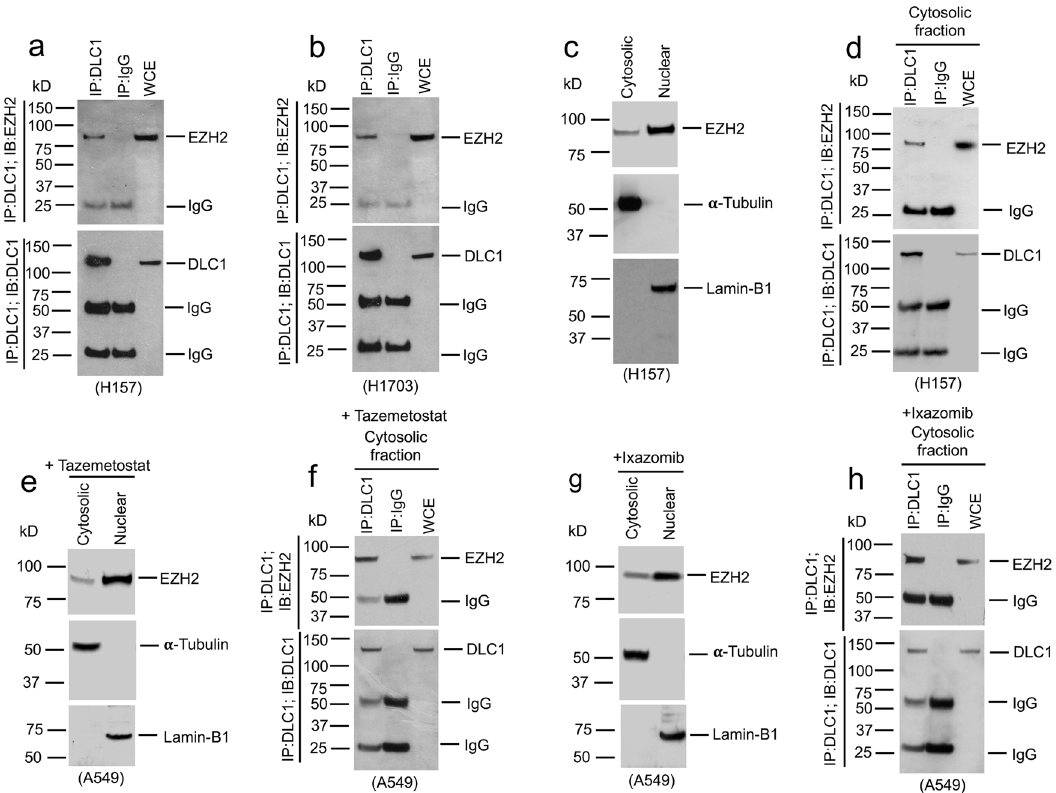
Fig. 6 Cytoplasmic EZH2 binds with DLC1. a , b Complex formation between DLC1 and EZH2. Lysates from H157 ( a ) and H1703 ( b ) cells were IP with DLC1, or mock IgG antibodies followed by IB with EZH2 (top) or DLC1 (bottom) antibodies. WCE, whole cell extract. c , d Complex between DLC1 and EZH2 occurred in the cytoplasm of H157 cells. c Nuclear (Lamin-B1) and cytosolic ( α -Tubulin) marker proteins con fi rmed the fractionation of H157 cells. d Extracts from cytosolic fraction of H157 were IP with DLC1 or mock IgG antibodies followed by IB with EZH2 antibodies (top) or DLC1 (bottom) antibodies. e – h Treatment of A549 cells with Tazemetostat ( e , f ) or Ixazomib ( g , h ) induced a cytoplasmic EZH2-DLC1 protein complex. A549 cells were treated with Tazemetostat or Ixazomib. Nuclear (Lamin-B1) and cytosolic ( α -Tubulin) marker proteins con fi rmed the fractionation of A549 cells after treatment with Tazemetostat ( e ) or Ixazomib ( g ). f , h Extracts from cytosolic fraction of A549 treated with Tazemetostat ( f ) or Ixazomib ( h ) were IP with DLC1, or mock IgG antibodies followed by IB with EZH2 antibodies (top) or DLC1 (bottom) antibodies. Two independent experiments were performed for a – h with similar results. Source data are provided as a Source Data fi